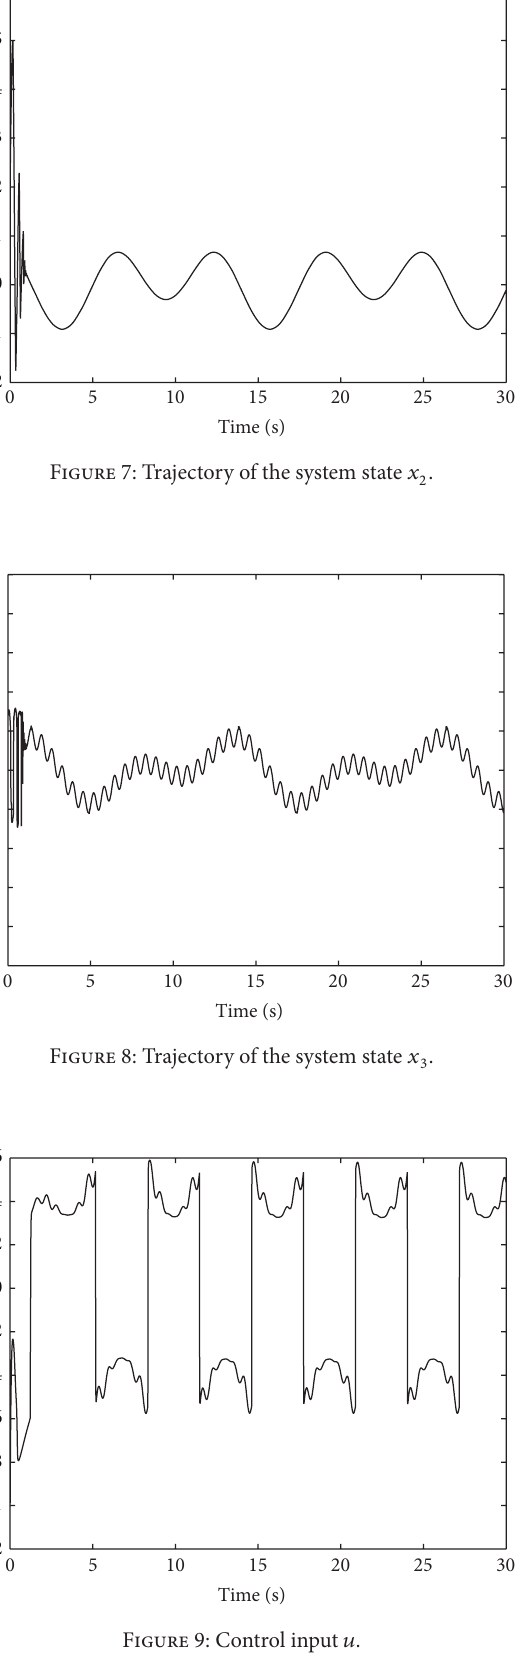
Figure 9: Control input 𝑢 .